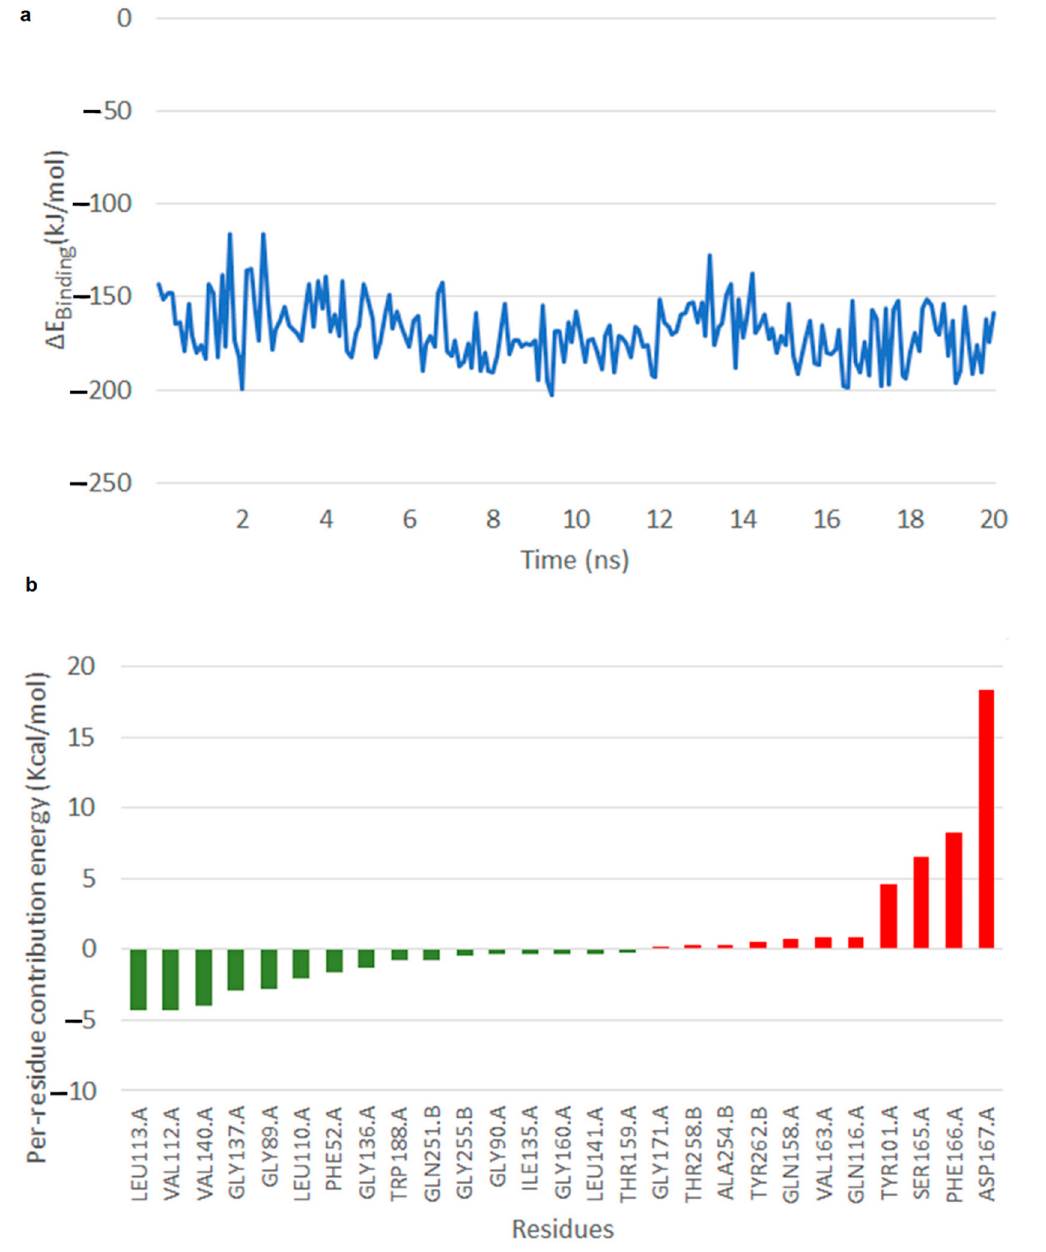
Figure 6. Interaction of NS with OMB. ( a ) Free energy of binding of the NS–OMB interaction. ( b ) Per residue energy graph.